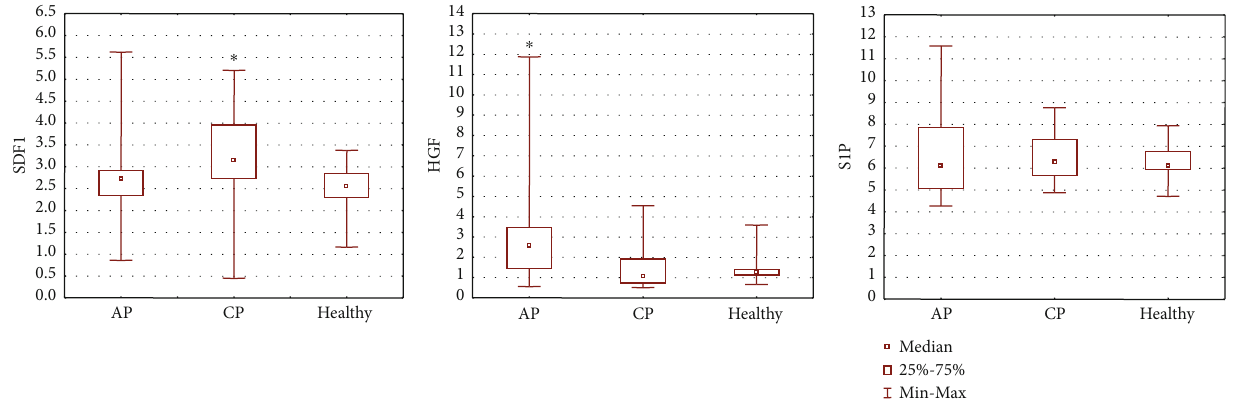
Figure 4: Serum concentrations of SDF1 α , HGF, and